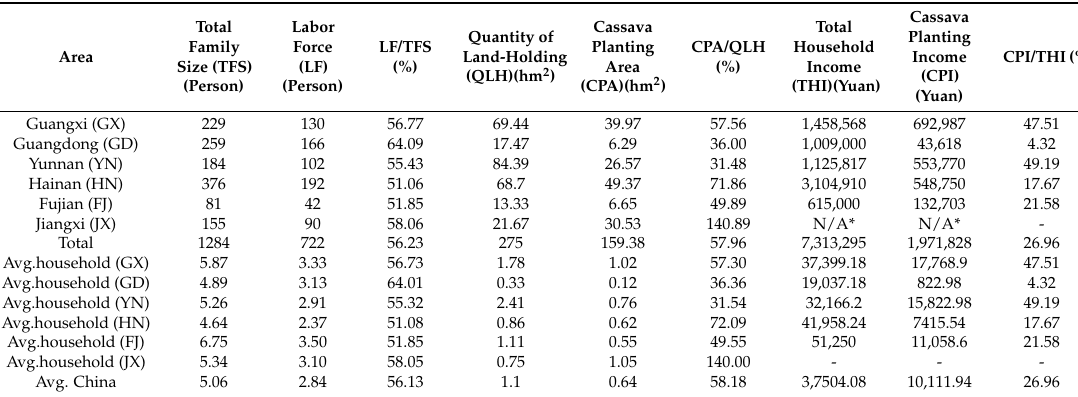
Table 3. Basic information of respondent (cid:48) s